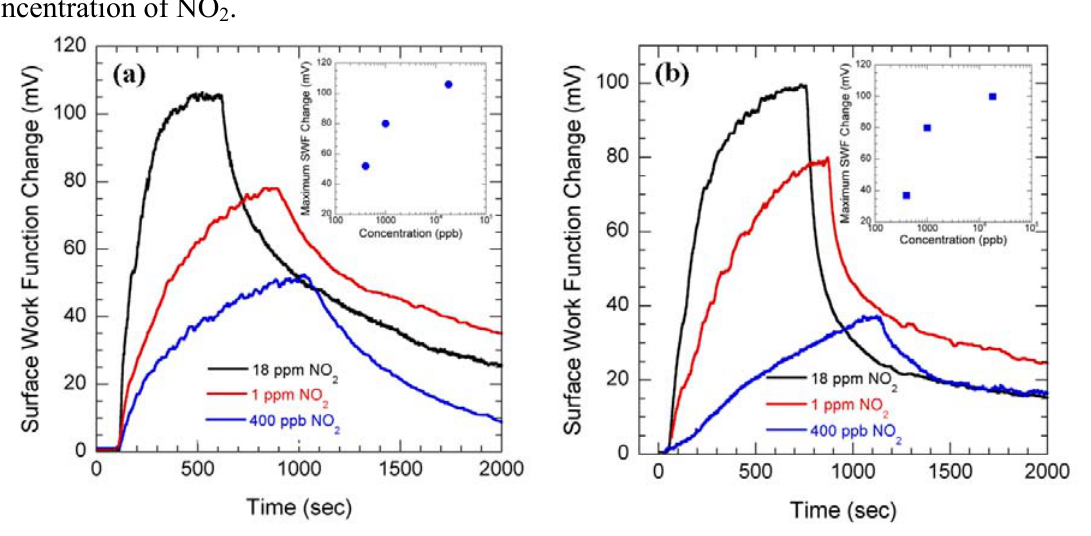
and (b) In O thin films as 18, 1 and 0.4 ppm NO 2 2 3 2